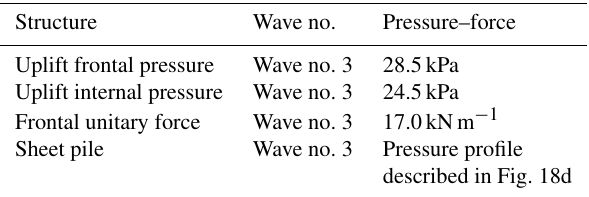
Table 6. Calculated design